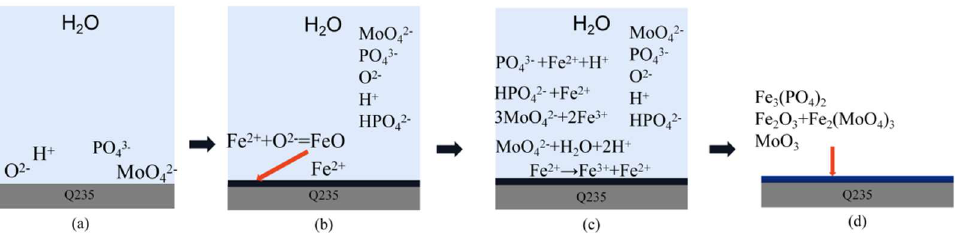
Figure 7. Reaction process of Q235 steel in low phosphorus passivation solution; ( a ) The matrix was just immersed into the passivation solution; ( b )The matrix surface produces a layer of FeO passivation membrane and phosphate hydrolysis; ( c ) Fe 2 + and Fe 3 + on the surface of the matrix react with the ions in the passivation fluid; ( d ) The formed passivation film is dried and then adsorbed to the matrix surface.